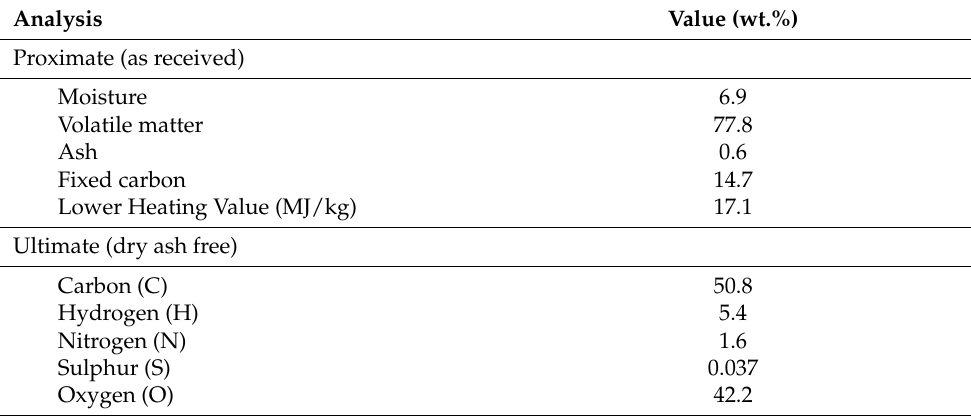
Table 1. Properties of pine wood